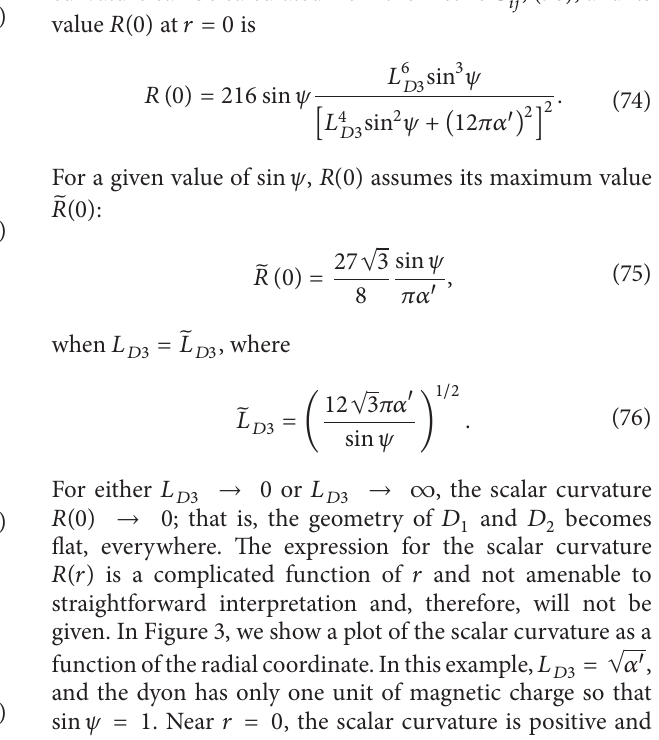
Each of the diagonal entries in the matrix 𝐺 󸀠 𝑖𝑗 corresponds to the metric on one of the 𝑛 𝐷3 -branes obtained from the 𝑇 -duality transformation. In the case of the first 𝑛 − 2 entries, corresponding to the 𝐷3 -branes 𝐷3 𝑛−2 , the metric is flat. In the case of the last two entries corresponding to the 𝐷3 -branes, 𝐷3 1 and 𝐷3 2 , their geometries are identical and intrinsically curved. The only feature which distinguishes 4 these two 𝐷3 -branes is that the function 𝑄(𝑟) defining the 𝑥 - coordinate for 𝐷3 -brane 𝐷 2 is replaced by −𝑄(𝑟) for 𝐷3 1 , as evidenced in (65) and (66a) and (66b) and (66c) and also in Figure 1. As a consequence, the electric and magnetic charges of the dyon on 𝐷 2 are minus the values on 𝐷 1 . The electric and magnetic field lines enter the wormhole from one 𝐷3 -brane and exit from the other. Figure 2 is an embedding diagram showing the 𝐷3 -branes 𝐷 1 and 𝐷 2 in the neighborhood of the radial coordinate 𝑟 = 0 . As there is no event horizon surrounding 𝑟 = 0 , the two 𝐷3 -branes are joined by a wormhole at 𝑟 = 0 . 𝐷3 𝑟 = 0 . The 1 and 2 , in the neighborhood of